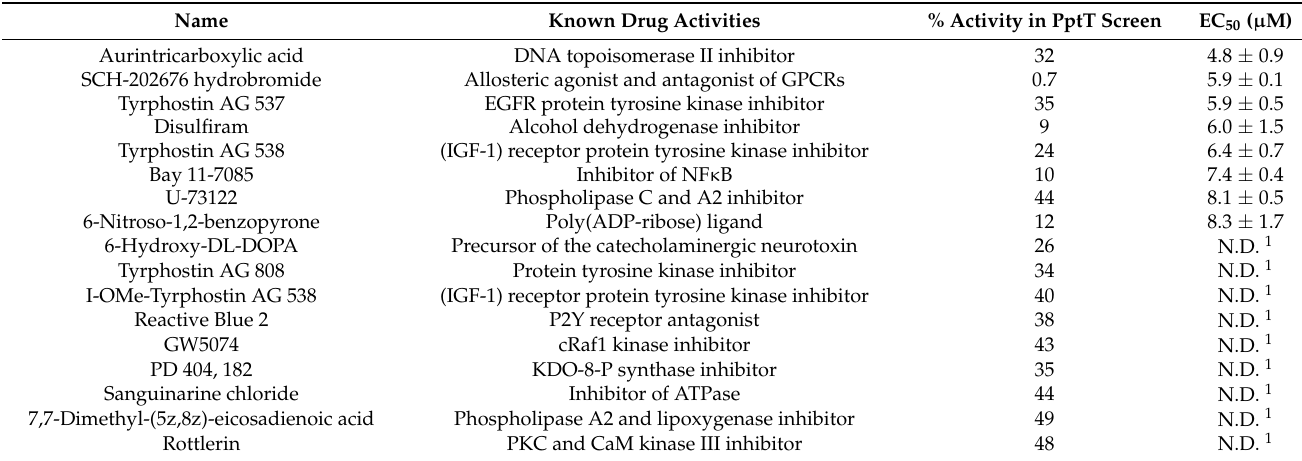
Table 1. PptT inhibitors recovered from BpsA screen. Names and descriptions were derived from the LOPAC 1280 manifest. EC 50 averages were calculated from three independent replicates ± standard